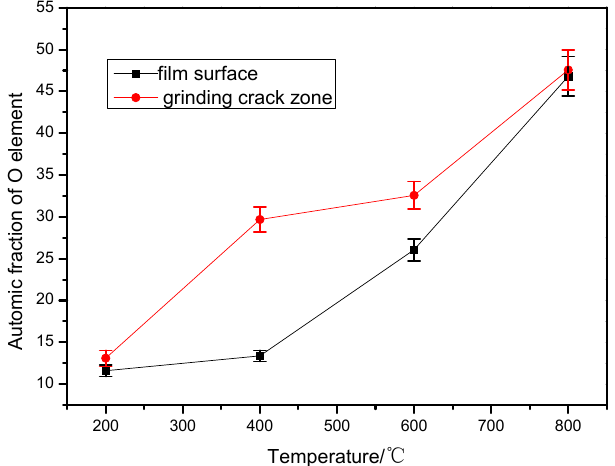
Figure 13. Atomic fraction of O element of the Cr 38.7 Ti 3.7 B 6.4 N 51.2 film after wear test at different temperature.